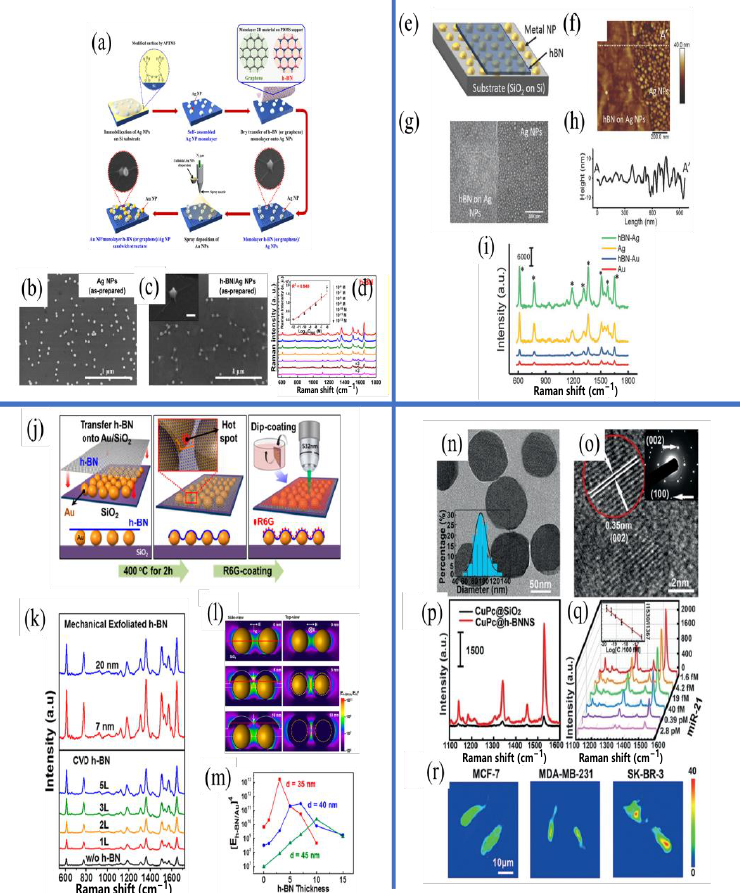
Figure 6. ( a ) Schematic illustration of the procedure for fabricating h-BN/Ag NP substrates and Au NP/h-BN/Ag NP sandwiched substrates. ( b , c ) SEM images of prepared Ag NP with or without h-BN covered. ( d ) Au NP/h-BN/Ag NP substrates with various molecular concentrations of R6G from 10 − 6 to 10 − 12 M. Reprinted from Ref. [81] with permission of 2019 American Chemical Society. ( e ) Schematic illustration of the h-BN/Ag SERS sample. ( f , g ) AFM and SEM images of h-BN/Ag SERS sample. ( h ) AFM line scan showing height variation along the white line marked in ( f ). ( i ) Representative Raman spectra for 10 − 3 M R6G obtained from h-BN and non-h-BN covered Au and Ag samples. The plots are offset vertically for clarity. Reprinted from Ref. [82] with permission of 2019 Wiley Online Library. ( j ) Schematic Illustration of Shell-Isolated SERS process on an h-BN/Au/SiO 2 substrate. ( k ) h-BN thickness-dependent SERS measurement of R6G on an h-BN/Au/SiO 2 substrate with layer numbers of h-BN from 0 to 5 layers. ( l ) Side-view and top-view simulation images (left and right columns, respectively) of EM field distribution on the h-BN (0, 5, and 10 nm)/Au/SiO 2 substrate (diameter of Au = 30 nm, bandgap = 40 nm, laser wavelength = 532 nm, incident E-field = 1 V/m). The position of the top-view simulation is marked by the red line in the side-view image. The h-BN film is marked by the white dotted line in the side-view image. ( m ) Plot of maximum EM field and h-BN thickness in the h-BN/Au/SiO 2 substrate with different bandgap values (35, 40, and 45 nm). Reprinted from Ref. [83] with permission of 2016 American Chemical Society. ( n ) TEM image of h-BN nanosheets. Inset: corresponding size-distribution histograms of h-BN nanosheets. ( o ) High-resolution TEM image of h-BN nanosheets. Inset: selected-area electron-diffraction pattern (SAED). ( p ) SERS effects of CuPc on SiO 2 and h-BNNS. ( q ) SERS spectra of intracellular miR-21 with CuPc@HG@BN. Inset: I 1530 /I 1367 versus intracellular quantity of miR-21. ( r ) Raman mappings. Reprinted from Ref. [84] with permission of 2019 Wiley Online